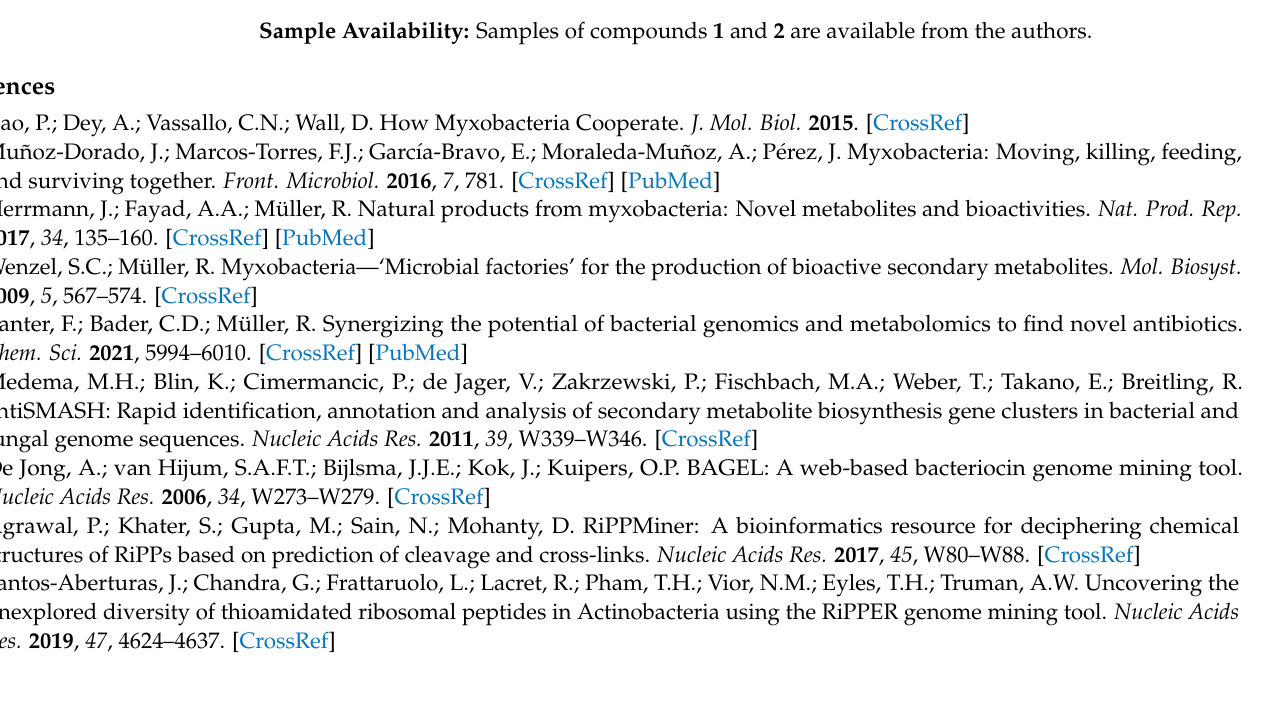
leucine amide) (FDLA), Figure S27. HPLC-MS extracted ion chromatograms (EICs) of 450.17317 m/z with a width of 0.005 m/z from Marfey’s derivatization reaction with commercial L -histidine standard and hydrolyzed 1 . Highlighted in green: D - L -product peaks; highlighted in blue: L - L -product peaks, Figure S28. Marfey’s derivatization reaction of L -tyrosine standard with L - respective D -(1-fluoro- 2,4-dinitrophenyl-5-leucine amide) (FDLA). In this case, we mainly observed the double derivatized product as shown above, Figure S29. HPLC-MS extracted ion chromatograms (EICs) of 770.27401 m/z with a width of 0.005 m/z from Marfey’s derivatization reaction with commercial L -tyrosine standard and hydrolyzed 1 . Highlighted in green: L - L - L -product peaks; highlighted in blue: D - L - D -product peaks, Table S1. Recipe for VY/2 medium, Table S2. Recipe for VY medium, Table S3. Recipe for CFL medium, Table S4. Recipe for P medium, Table S5. Recipe for M medium, Table S6. Recipe for YM medium, Table S7. Recipe for CTT medium, Table S8. Recipe for AMB medium, Table S9. List of study, Table S11. List of PCR-amplified constructs, Table S12. List of plasmids used in this study, Table S13. List of genetic constructs generated in this study, Table S14. NMR spectroscopic data of 2 measured in methanol-d 4 at 700/175 MHz, Table S15. NMR spectroscopic data of 1 measured